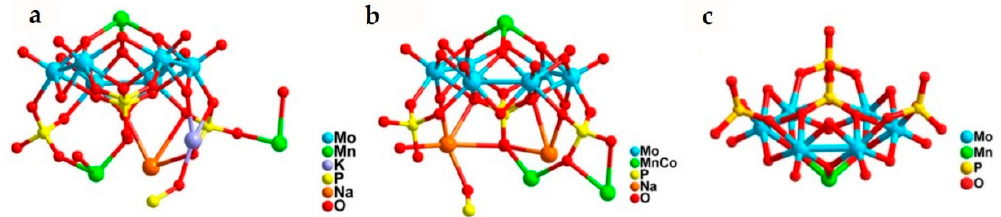
Figure 9. The asymmetric units of NENU-605 ( a ), NENU-606 ( b ) and NENU-607 ( c ). Reprinted with permission from [50]. © 2019 Attribution-Non Commercial 3.0 Unported Licence (CC BY-NC 3.0).